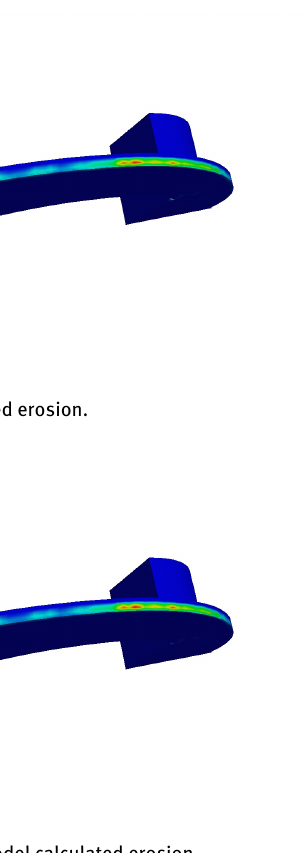
shown in Equation (3).